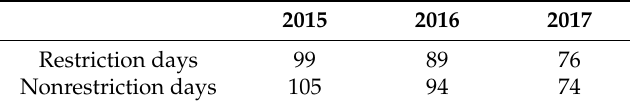
Table 2. Comparison of AQI on restriction days and nonrestriction days in different years.